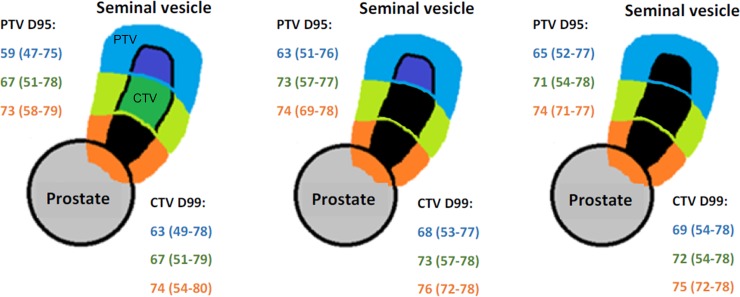
Dosimetric characteristics of each third of the seminal vesicle, depending on the length of involved seminal vesicles on MRI.Mean value (range) in Gy; Dx: dose delivered to x% of volume; PTV: planning target volume; CTV: clinical target volume; SV: seminal vesicle; SV PTV = SV CTV + 5 mm in all directions. Each SV was divided in three equal thirds, according to the cranio-spinal axis. The mean dose for each third of both SV is represented. The proximal third of the seminal vesicle is in orange, the second third is in green, and the distal third is in blue. The involved part of the seminal vesicle is in black.